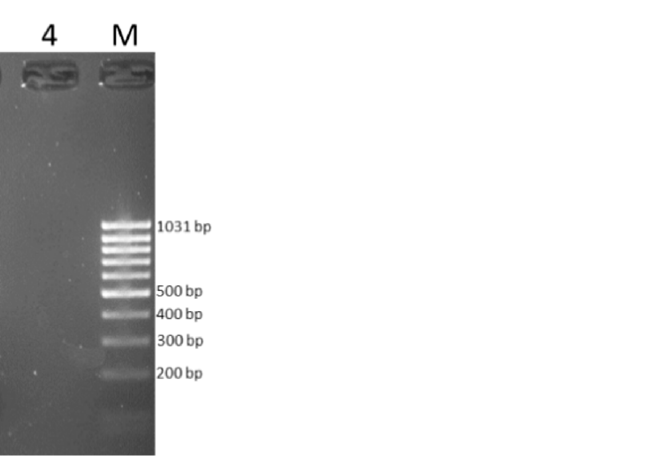
Figure 1. PCR amplicons. Lane 1, 267 bp tet (L) gene fragment; lane 2, 406 bp tet (M) gene fragment; lane 3, 515 bp tet (O) gene fragment; lane M, MassRuler Low Range DNA Ladder, (Thermo Fisher Scientific, Vilnius,